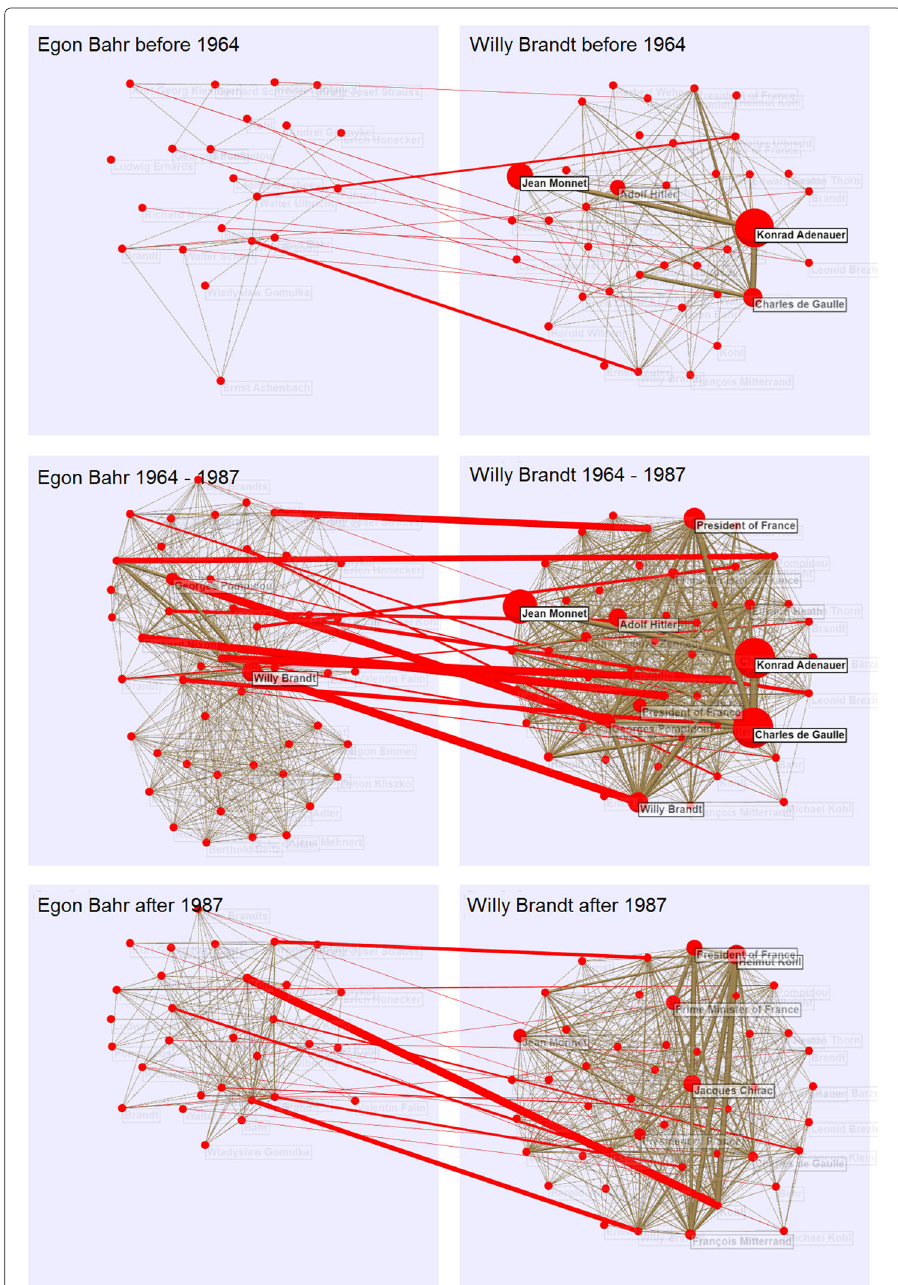
Fig. 3 Comparing graphs. Co-evolution of two dynamic networks over consecutive time periods